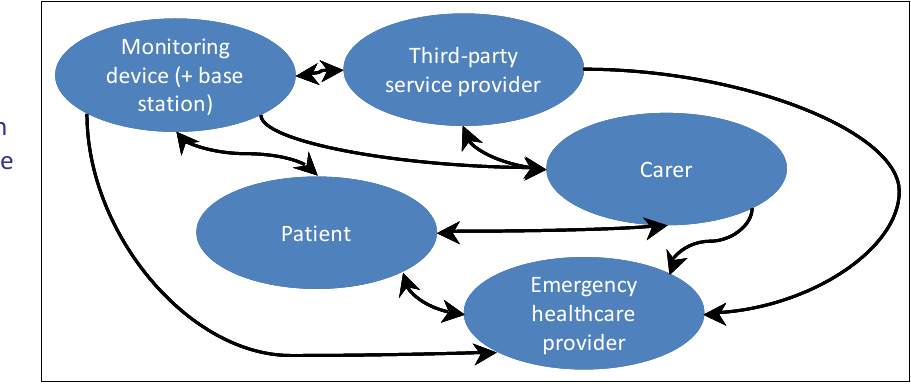
Potential for mobile networks to support communications between the five basic nodes of